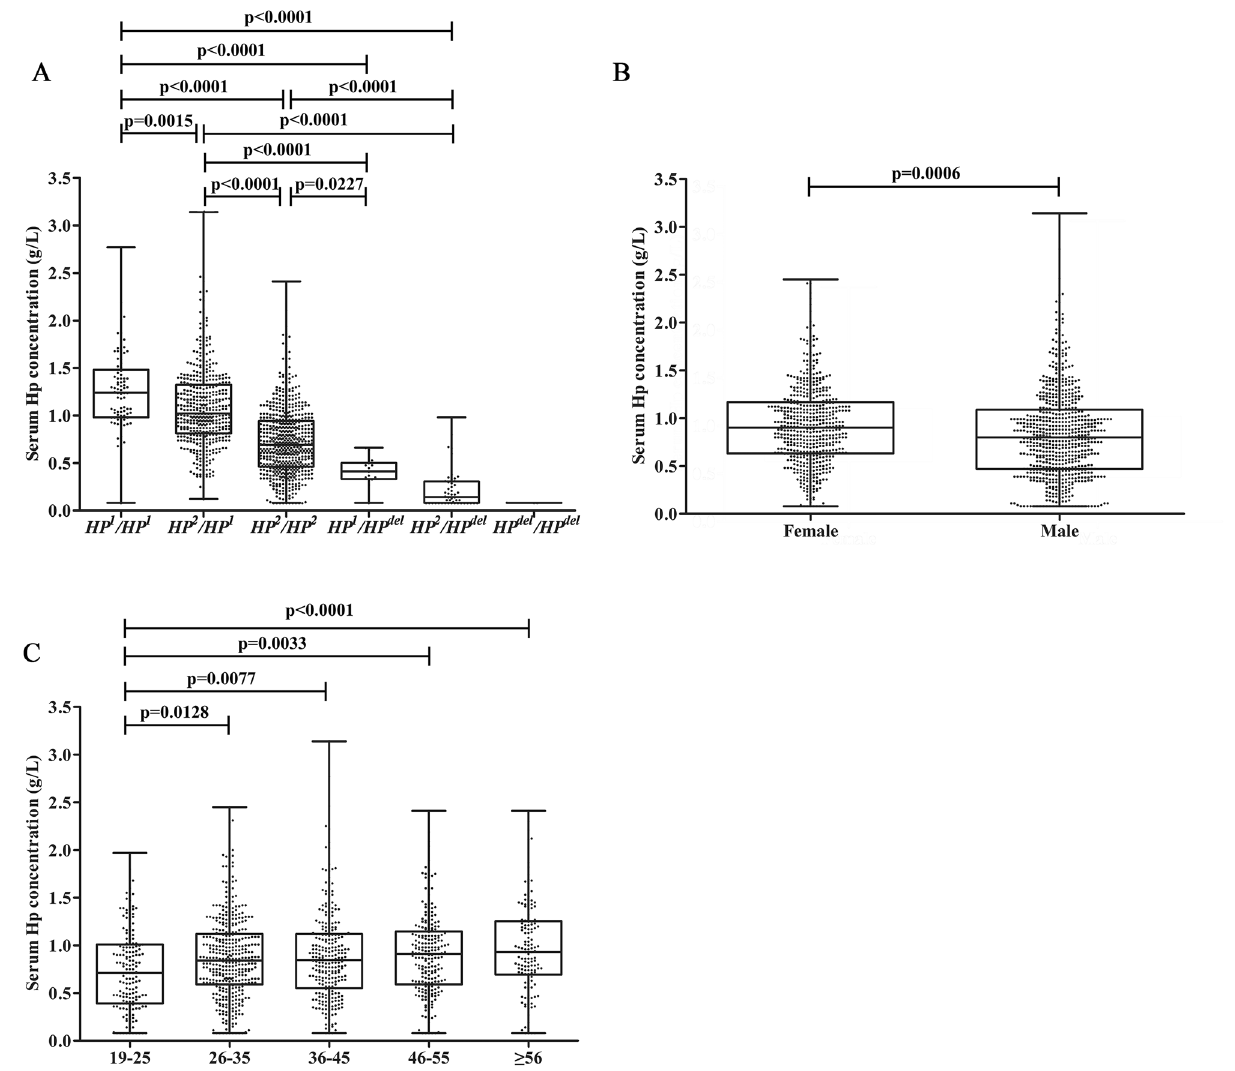
Figure 2. Distribution of HP concentration among various subtypes ( A ), genders ( B ), and ages( C ). Data are presented by box & whiskers (median + 25 & 75 percentiles, min to max).